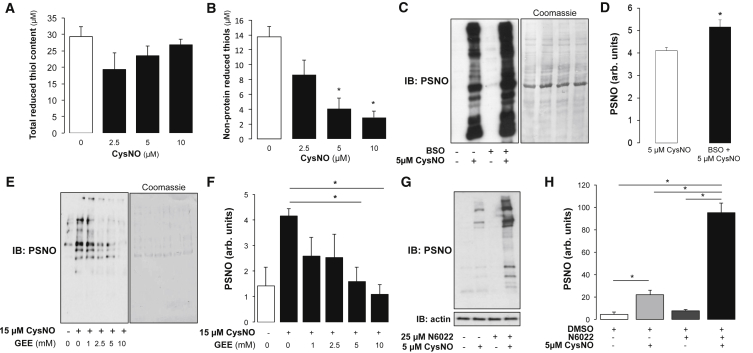
Detection of S-Nitrosothiols Is Dependent on the Abundance of GSH(A and B) Ellman’s assay was performed to detect total and non-protein thiols in SMCs exposed to CysNO for 30 min. Although there was no change in total thiol concentration (A), a significant decrease in non-protein thiols was observed with increasing CysNO concentration (B).(C) Glutathione synthesis was inhibited in SMCs for 24 hr using buthionine sulfoximine (BSO) to deplete the cellular GSH concentration. SMCs exposed to CysNO were analyzed for PSNO content using the biotin switch method.(D) Depletion of GSH significantly increases detectable PSNO.(E) SMCs were exposed to CysNO, followed by treatment with increasing doses of GSH ethyl ester (GEE) to augment cellular GSH concentration.(F) A dose-dependent decrease in PSNO was detected after treatment with GEE, reaching significance at 5 mM GEE.(G) SMCs were pre-treated with or without the S-nitrosoglutathione reductase inhibitor N6022 for 1 hr prior to exposure to CysNO.(H) Exposure to N6022 significantly potentiated the accumulation CysNO-induced PSNO.Data are represented as mean ± SEM; ∗p < 0.05.